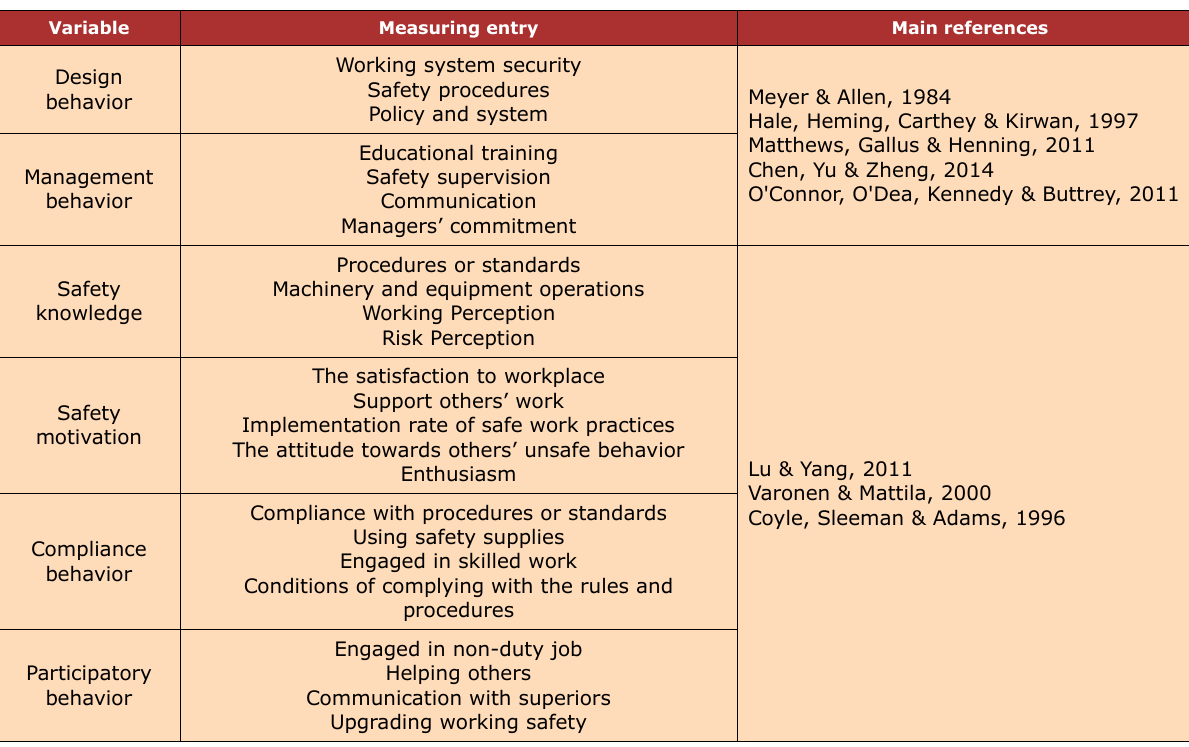
Table 1. Research Variables and Measurement